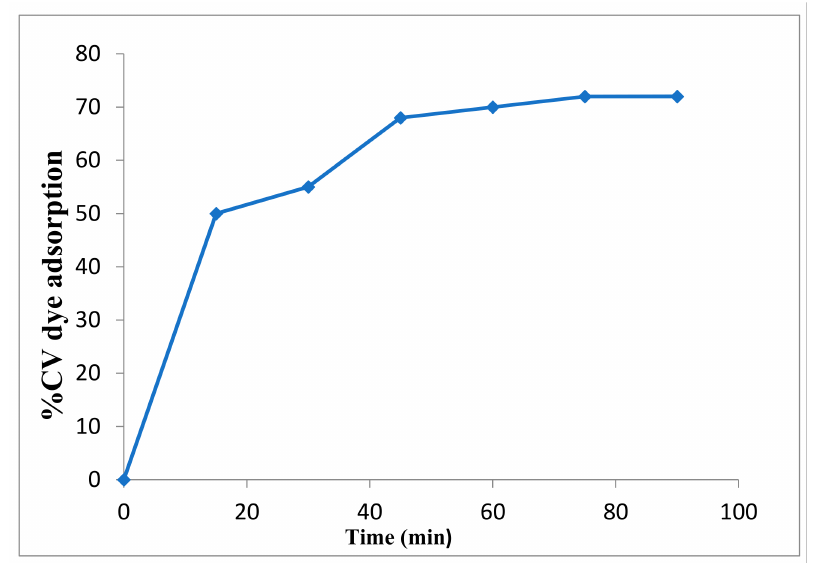
Figure 4. Kinetic of CV dye adsorption onto natural iron oxide ((CV) = 10 mgL − 1 , m cat = 0.1 g, T = 25 ◦